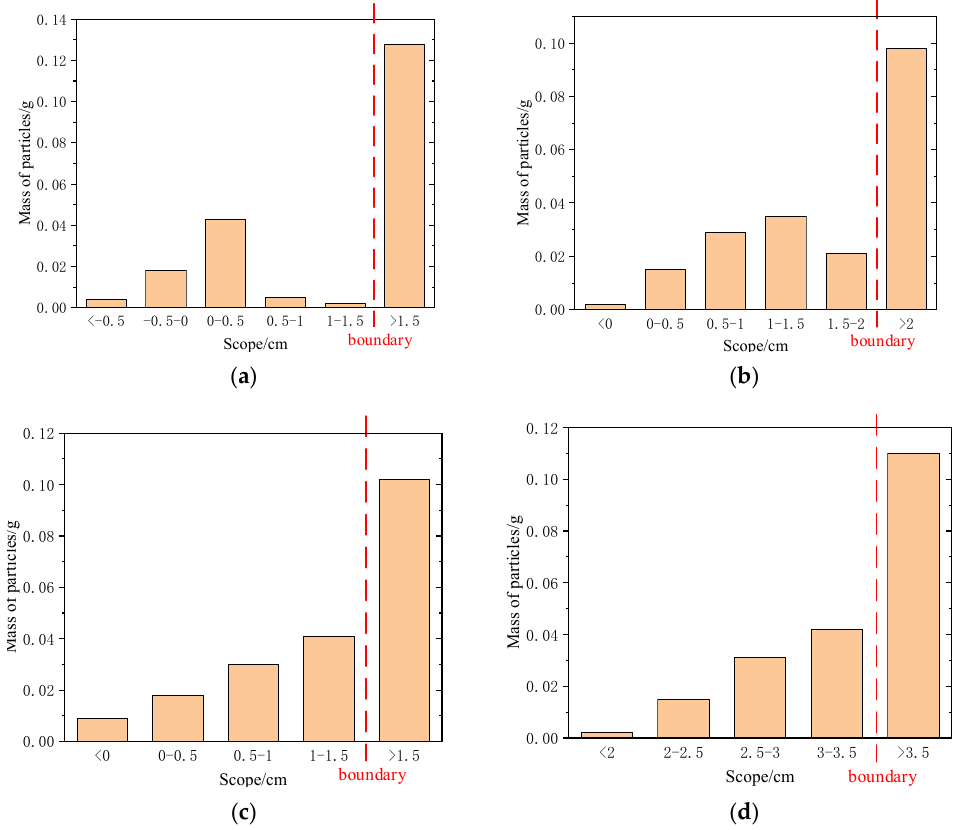
Figure 14. Mass distribution diagram: ( a ) Trap 1, ( b ) Trap 2, ( c ) Trap 3, and ( d ) Trap